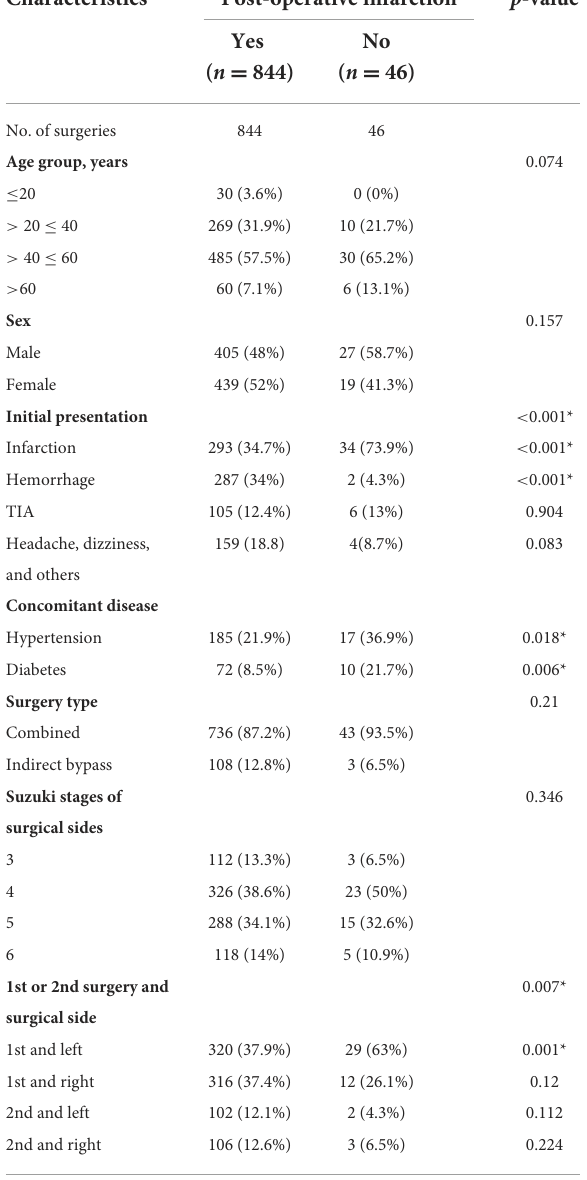
TABLE 3 Demographic characteristics and risk factor analysis of postoperative infarction. Characteristics